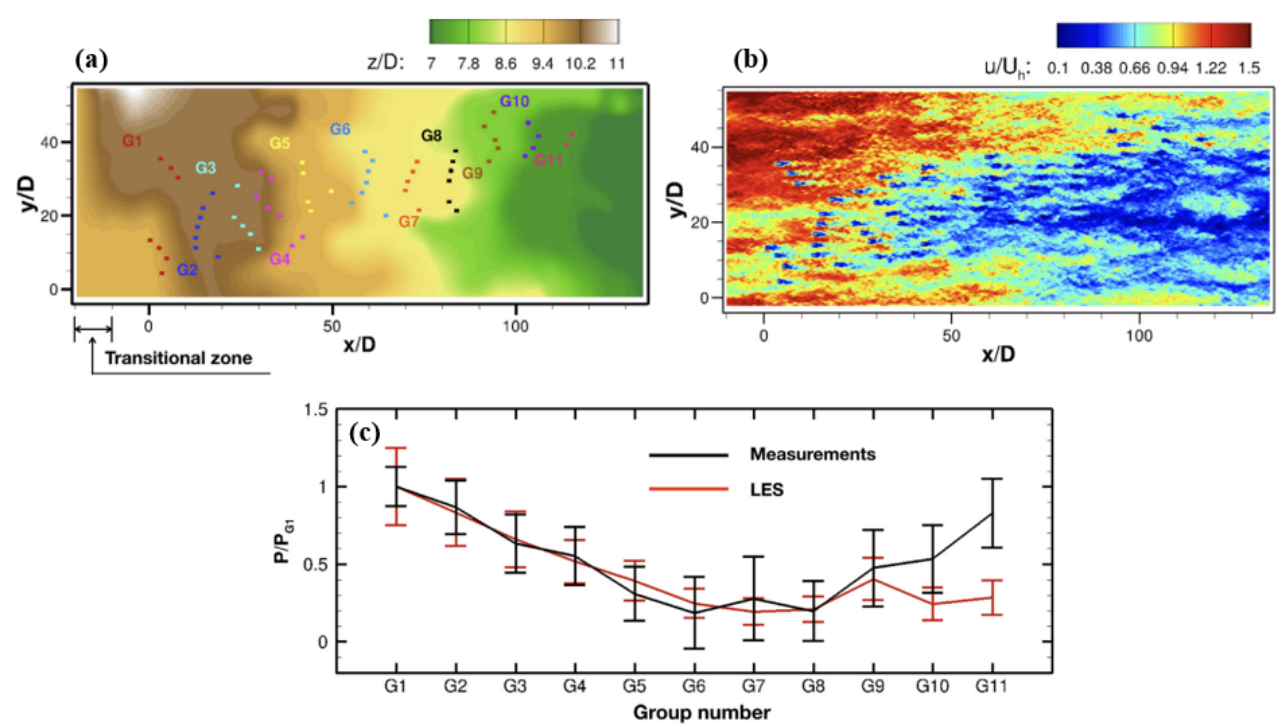
Figure 14. Results from the AL-LES simulation of the flow inside a wind farm over complex terrain for ( a ) contour of the terrain elevation, ( b ) instantaneous downwind velocity, and ( c ) comparison of the simulated power outputs with measurements. Reprinted from Yang et al. [132] with permission, 2018,